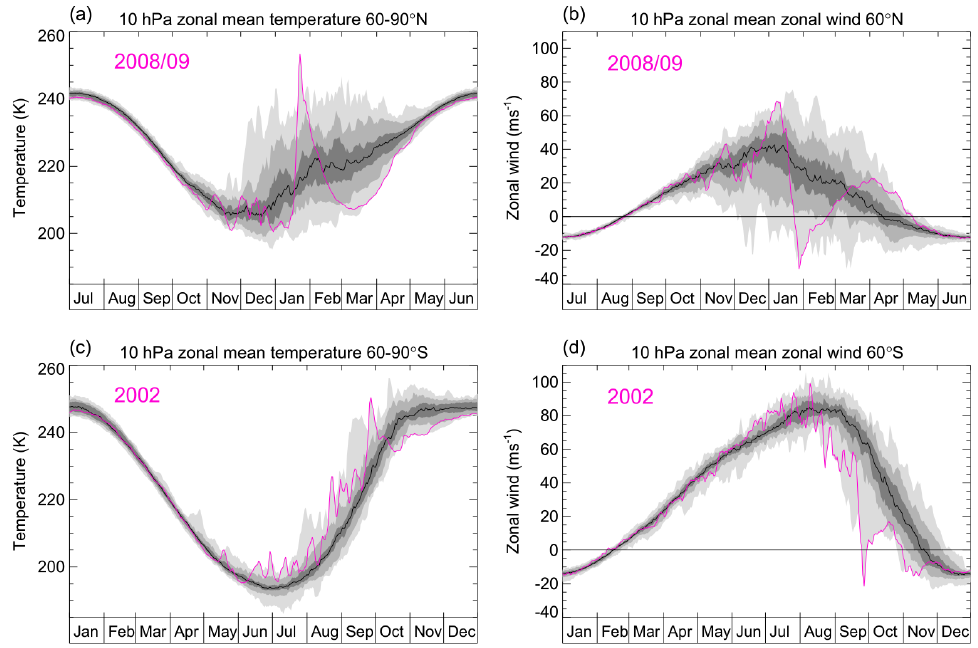
Figure 8. Daily temperature and winds from MERRA2 data (Gelaro et al., 2017) for 1979–2020. The black line is the multi-year average of the daily time series with the 30th/70th and 10th/90th percentiles and the range shown by the dark, medium and light grey shading, respectively. The purple lines show the daily values for year 2008/09 in the NH and 2009 in the